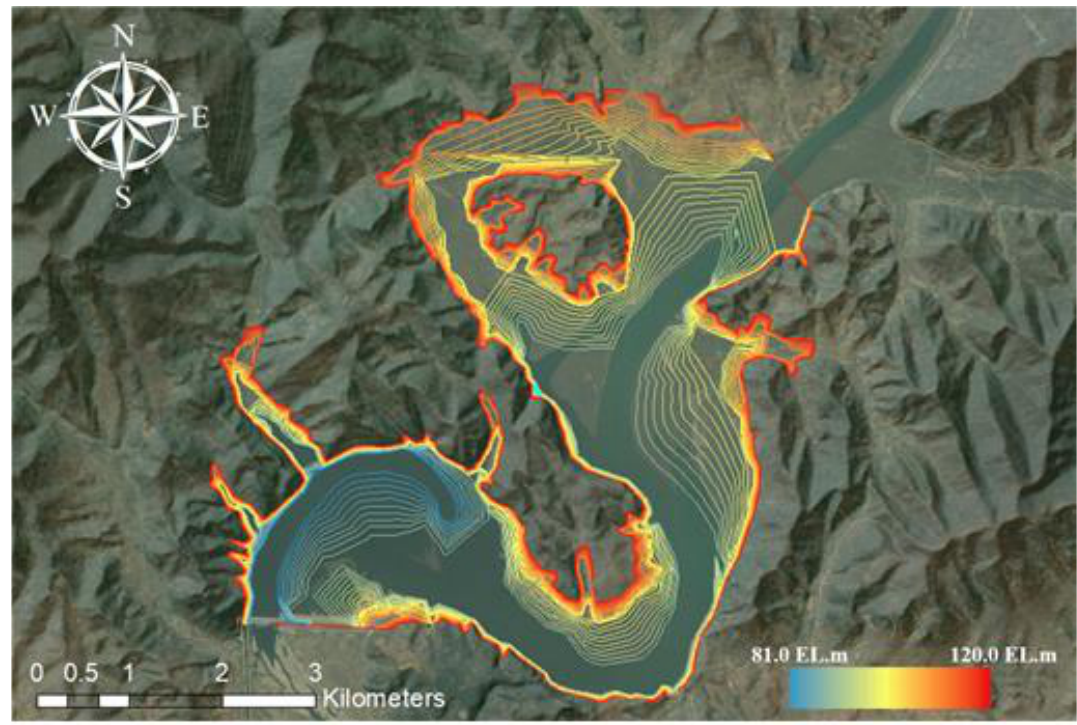
Figure 3. The contour map of the Hwanggang Dam reservoir in North Korea.